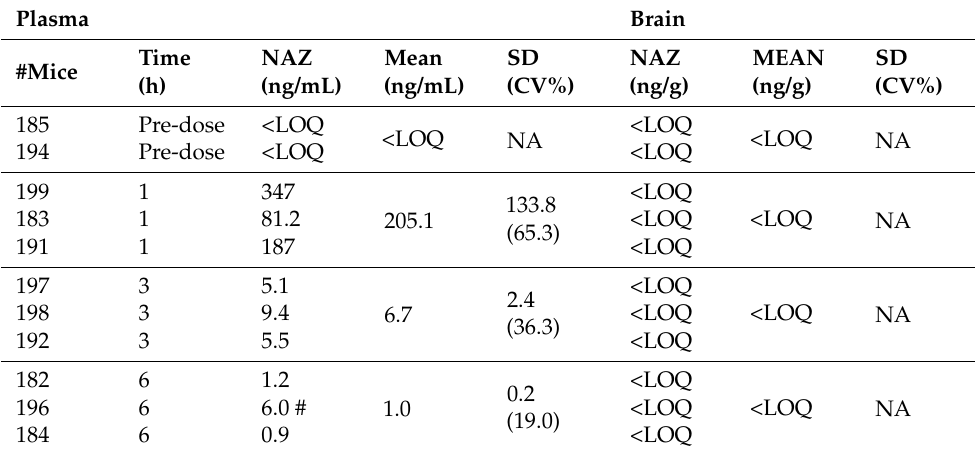
Table 7. NAZ concentrations in the plasma and brain tissue of healthy mice treated i.p. at a dose of 15 mg/kg (3 times/week for 2